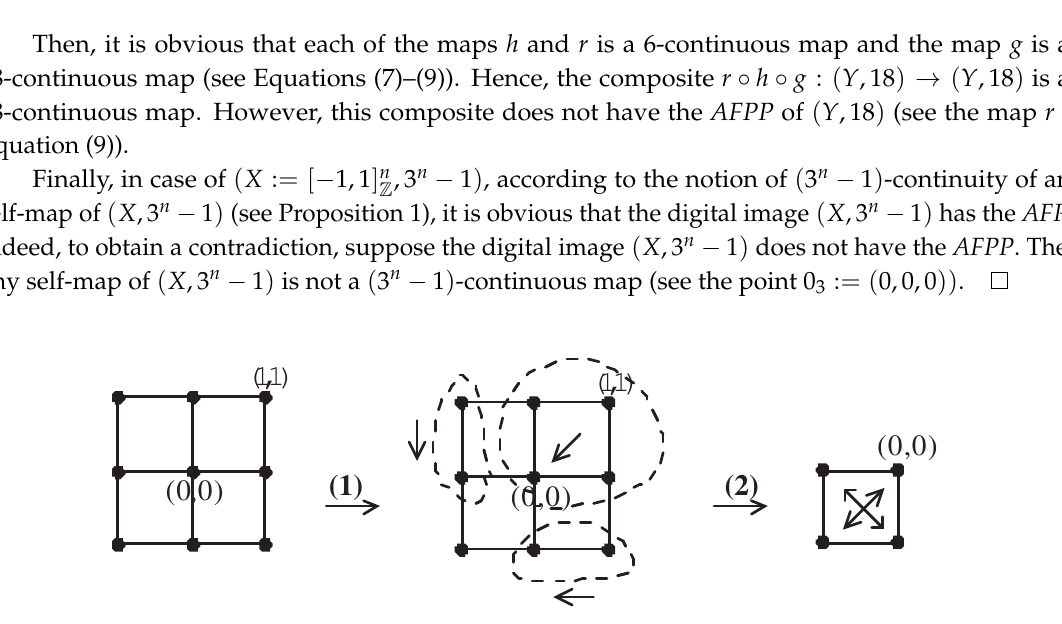
Figure 1. The non- AFPP of the digital 2-cube with 4-adjacency, ([ − 1,1 ] 2 Z : = X ,4 ) . (1) Configuration of the map f 1 ; (2) Explanation of the map f 2